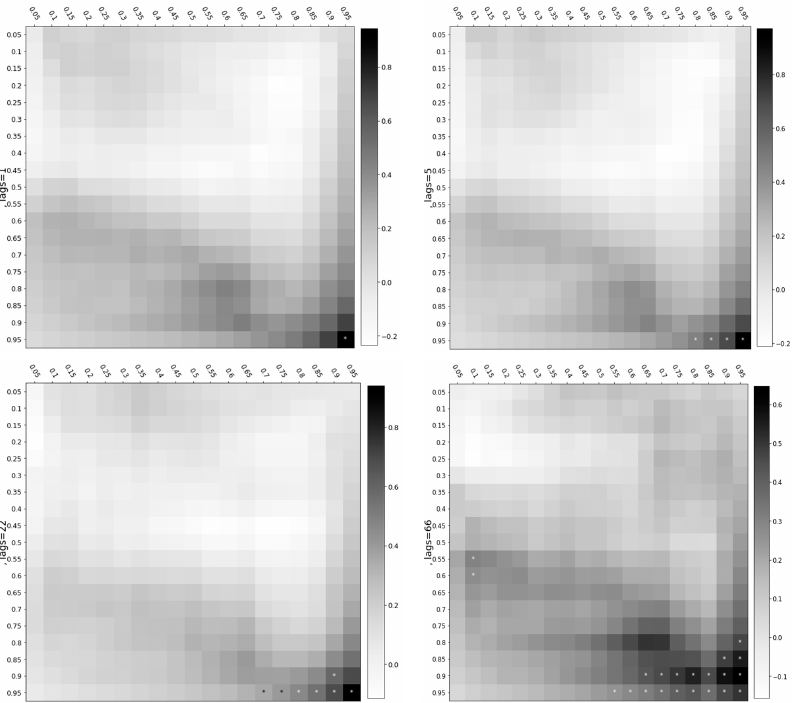
Figure 12. Cross-quantile dependency from Pfizer to Moderna. Notes: The vertical axis indicates the quantile distribution of Pfizer’s stock return, whereas the horizontal axis indicates the quantile dis- tribution Modena’s stock return. The white-to-black intensity in the bar indicates negative to posi- tive associations. Figure 13 demonstrates the cross-quantile dependency from Johnson & Johnson to Moderna. Johnson & Johnson under the higher quantiles transmits positive volatility spill- overs to Moderna under the middle quantiles in the short term. In the long term, a pro- nounced impact of Johnson & Johnson is observed under bullish conditions.